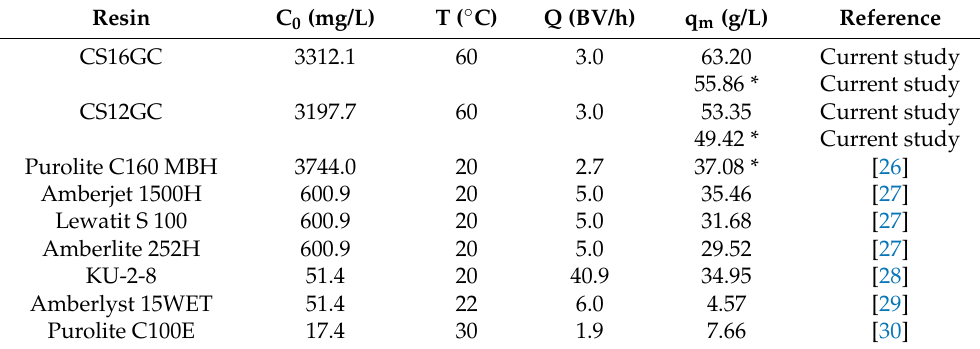
Table 4. Comparison of operating capacities towards NH 4+ of different strong-acid cation-exchange resins in column